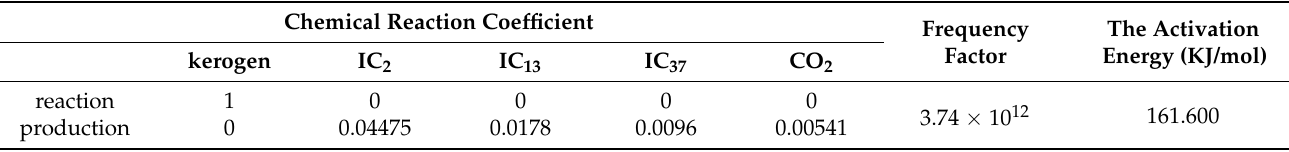
Figure 2. Sketch of 2D reservoir model in this example. ( a ) this model; ( b ) Computer Modeling Group (CMG) model. Table 1. Chemical reaction coefficient of kerogen pyrolysis.